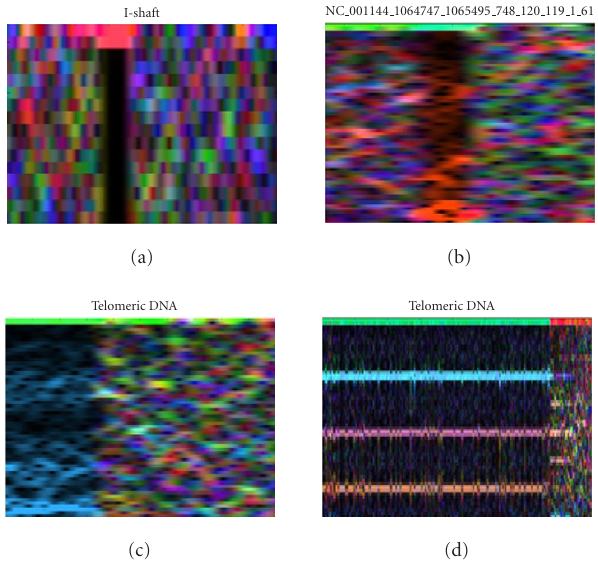
Figure 23: Four spectrograms showing very simple regions. (a) and (b) correspond to simple (1 and 3bp) repeats in intergenic regions, while (c) and (d) show subtelomeric DNA found at the end of chro-